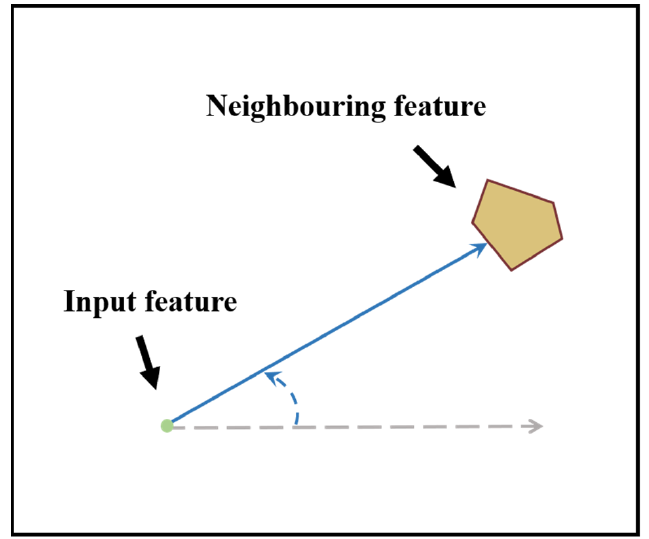
Figure 4. Calculation of the minimum distance between a heritage site and the neighbouring town boundary.